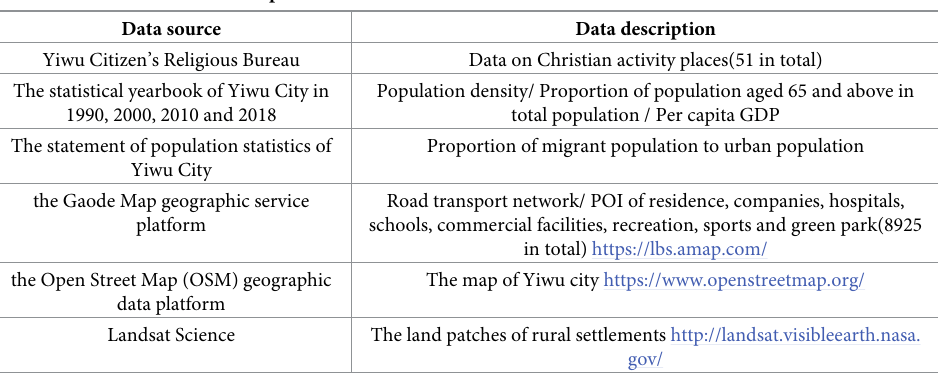
Table 2. Data sources and